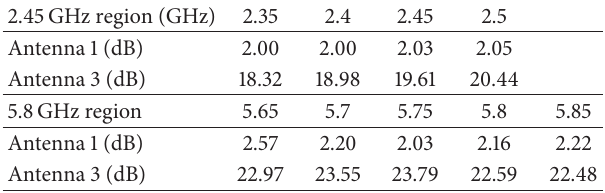
Table 2: Parameters of the optimized reference antenna design. Table 3: Comparison of F/B ratios for antenna 1 and antenna